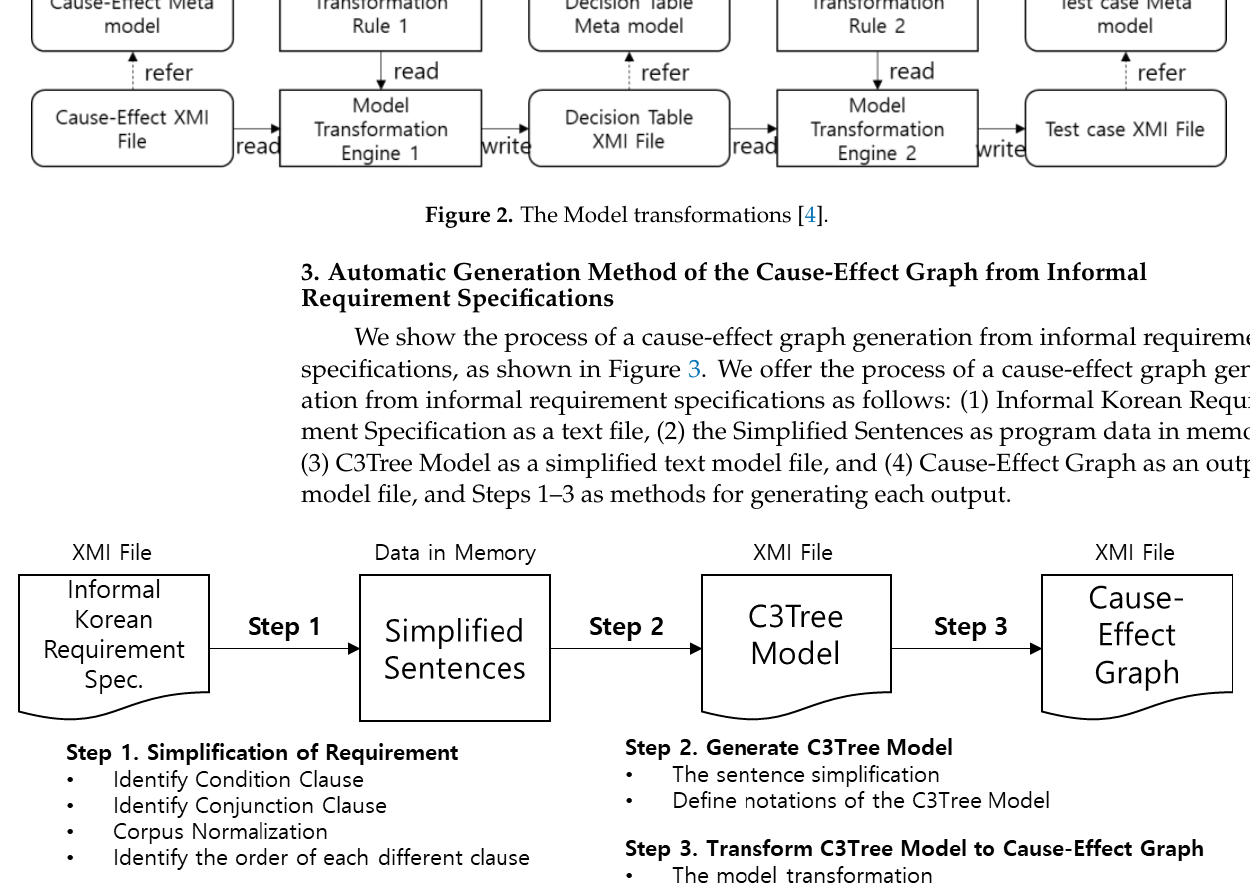
Figure 3. The Process of Cause-Effect Graph Generation from Informal Requirement Spec.